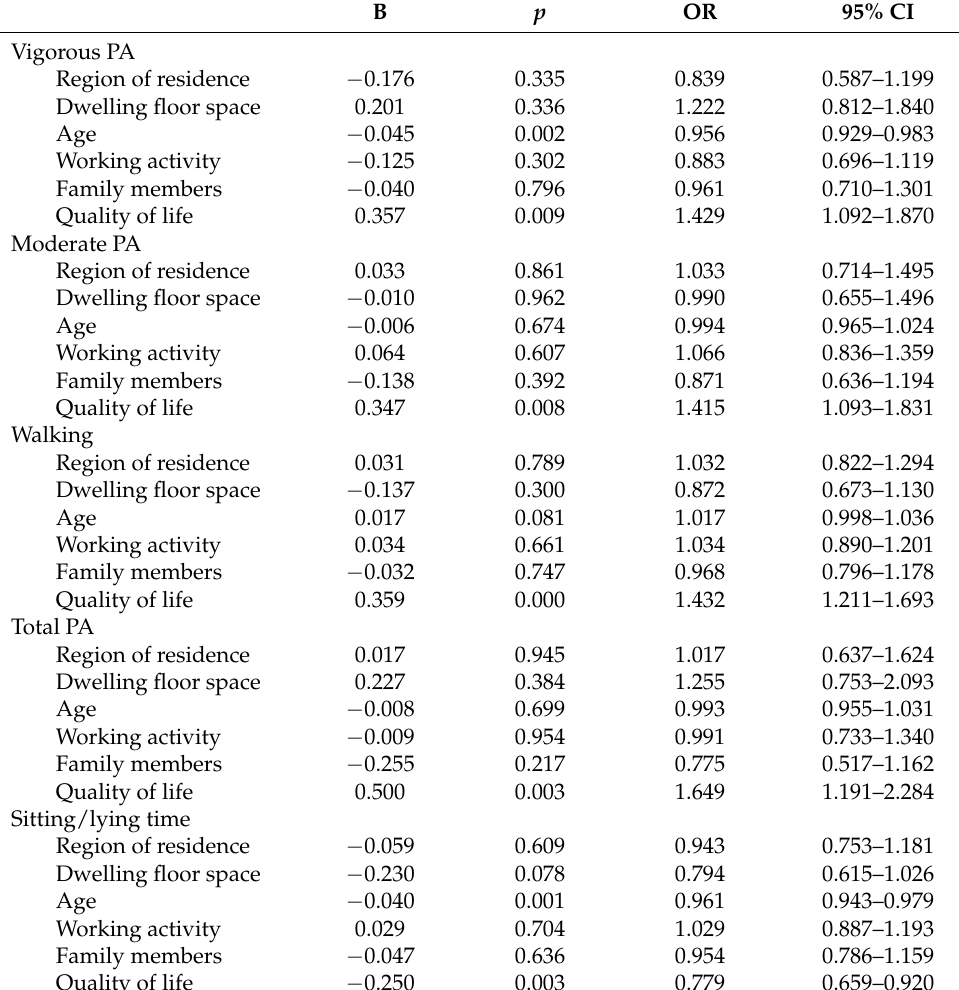
Table 7. Logistic regression analysis between possible independent predictors and physical activity level (MET-min/week) or sitting/lying time (h/day) in the DianaWeb cohort during